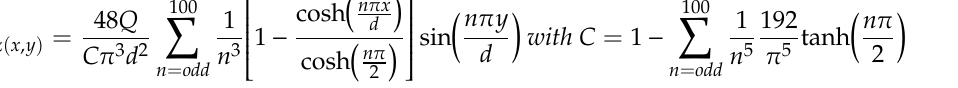
at outlet and final merging